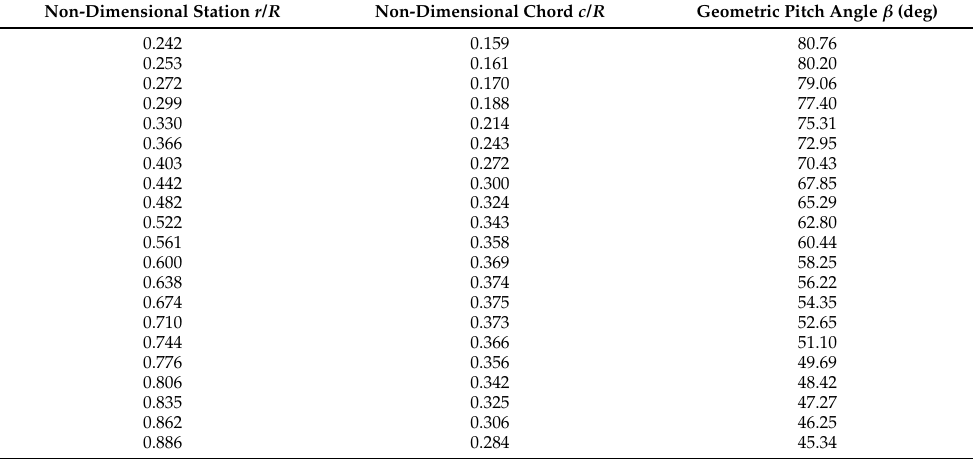
Table A1. XROTOR geometric data. Non-Dimensional Station r / R Non-Dimensional Chord c /